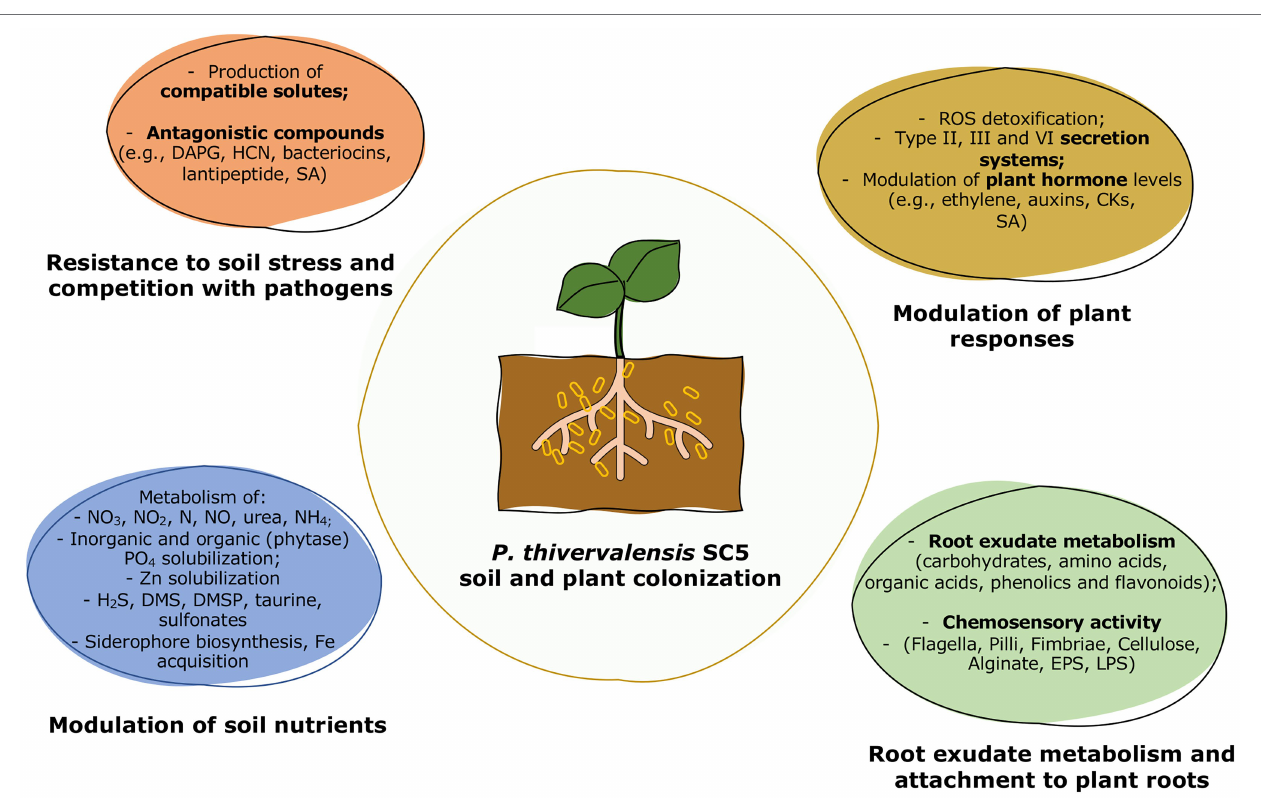
FIGURE 4 | Overview of the P. thivervalensis SC5 soil and plant colonization activities.